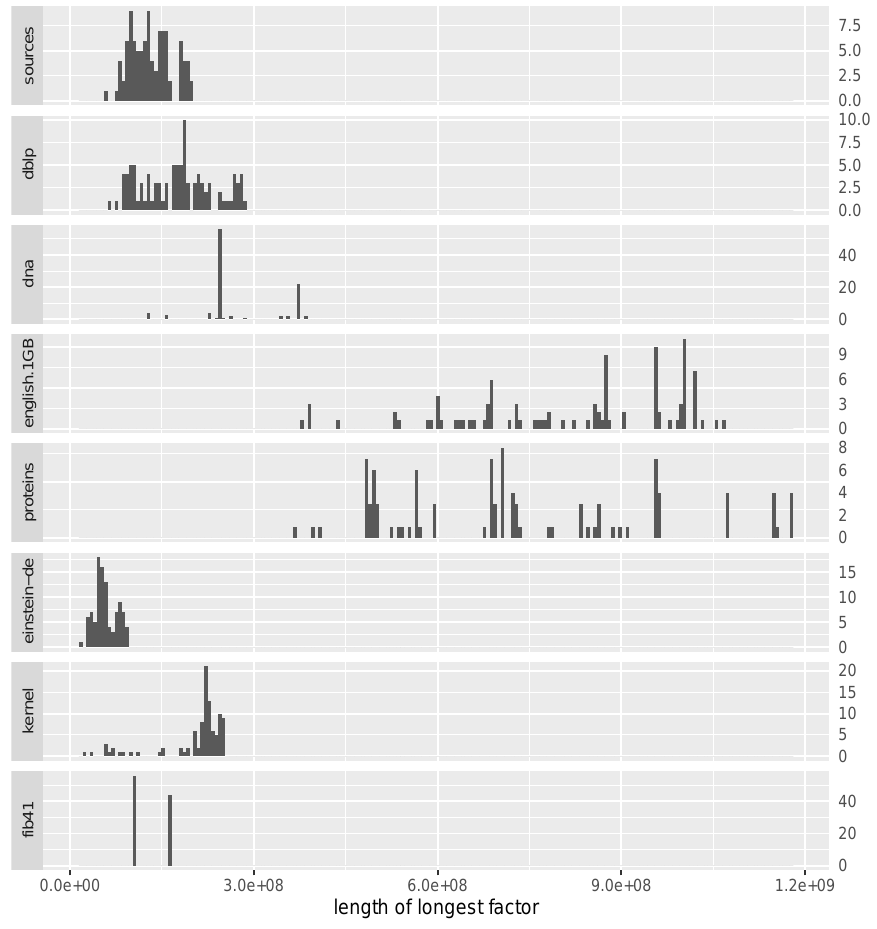
Figure 4. Longest length of factors for random permutations of the alphabet. Shapiro–Wilk normality tests, with p = 0.05, discarded normality of all